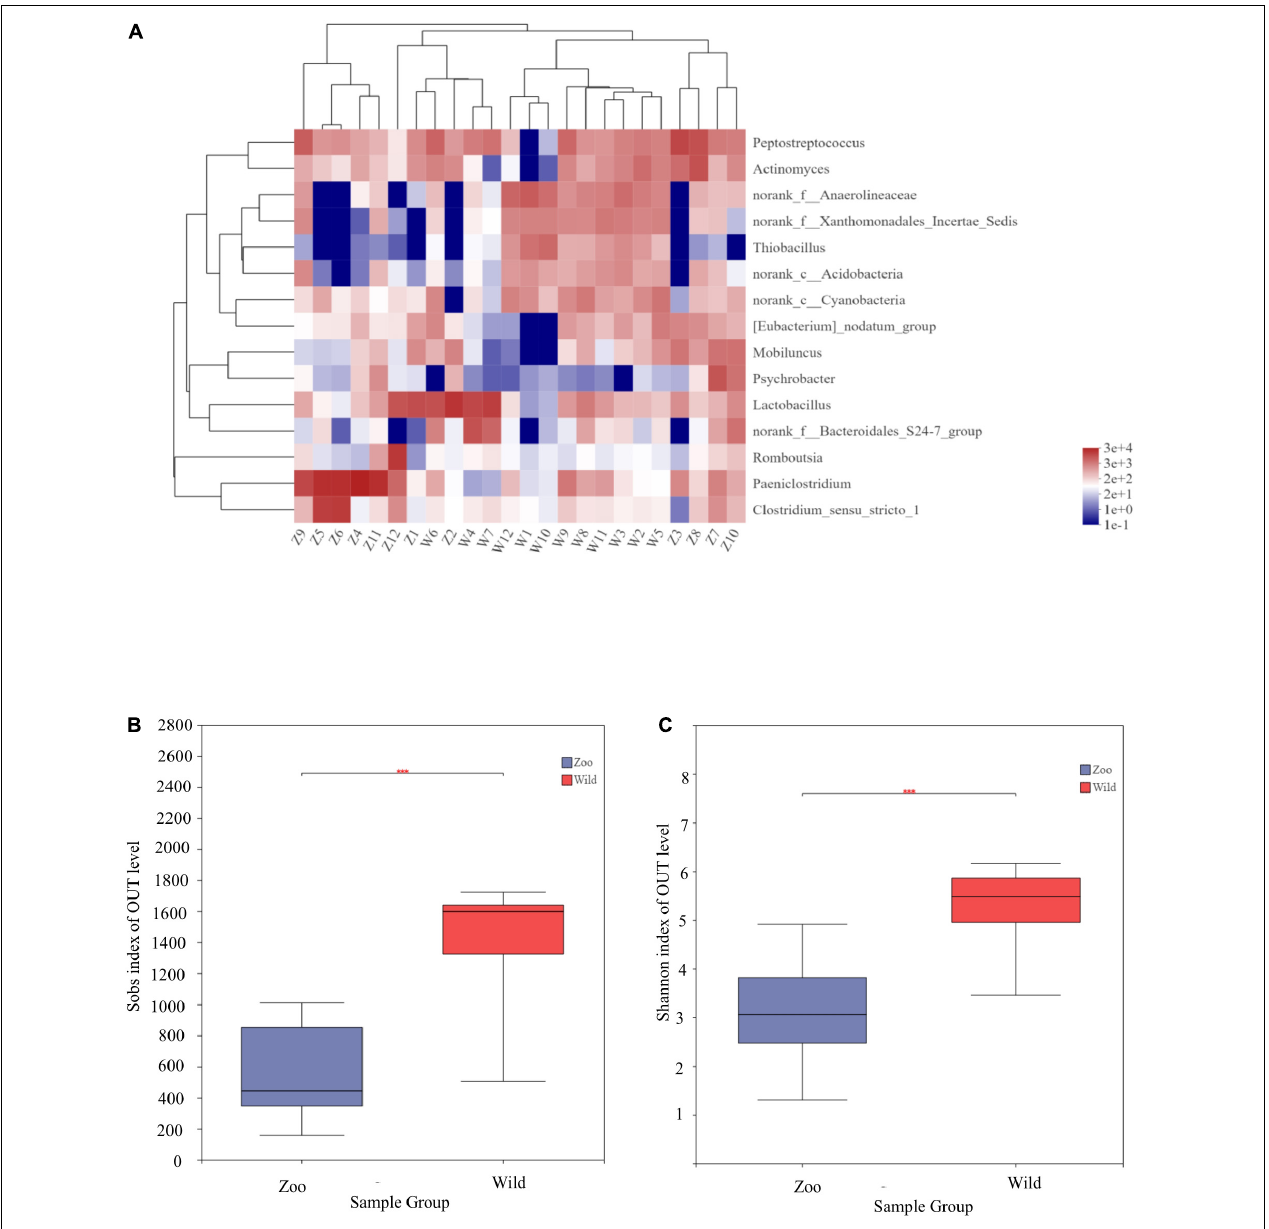
FIGURE 2 | Community heatmap analysis at genus level and α -diversities of gut microbiota among the two populations. (A) Community heatmap analysis on genus level. (B) Bacterial community richness (measured by Sobs index) in the Z and W groups. (C) Bacterial community diversity (measured by Shannon index) in the Z and W groups. p < 0.05 was considered statistically significant. *** P ≤